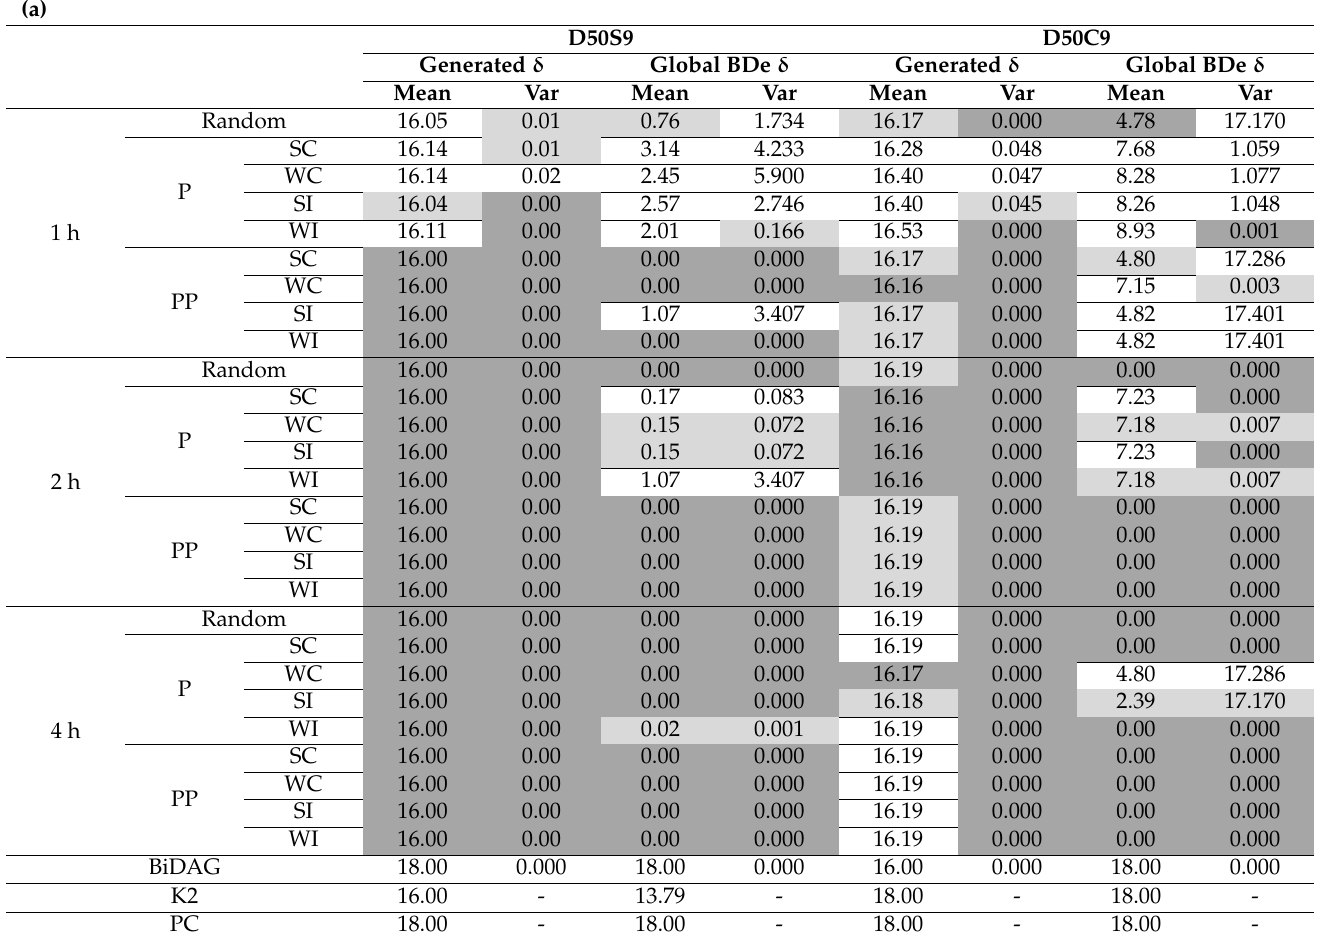
Table 6. Markov blanket distances without the order weight. (a) 50 cases datasets. Dark shaded cells represent the lowest distance or variance in each timed run for the dataset; Bright shaded cells represent the second lowest distance or variance in each timed run for the dataset. (b) 1000 cases datasets. Dark shaded cells represent the lowest distance or variance in each timed run for the dataset; Bright shaded cells represent the second lowest distance or variance in each timed run for the dataset.